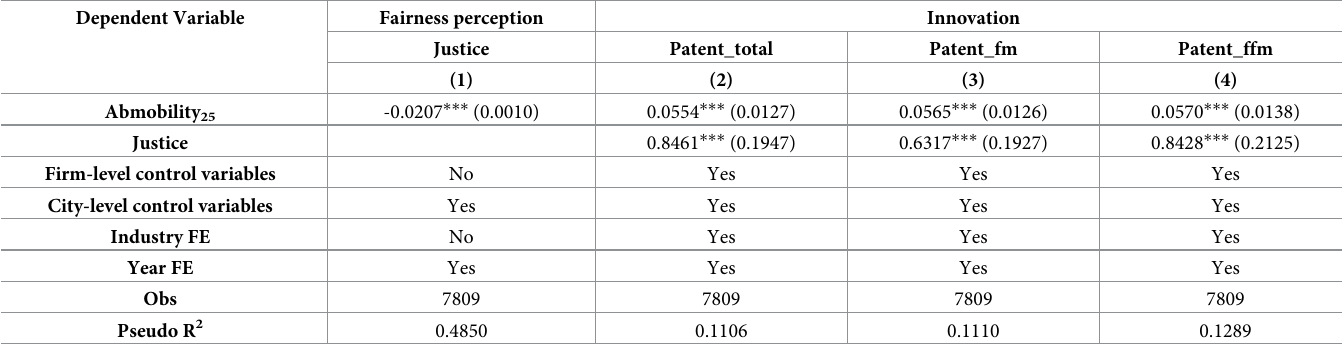
Table 4. Mediating effect tests: Fairness